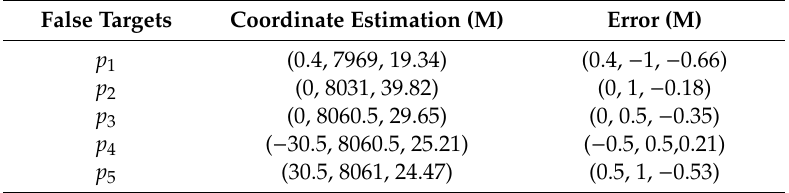
Figure 3. False point targets simulation based on three transponders. ( a ) SAR image in the antenna A 1 . ( b ) Absolute interferogram after unwrapped. ( c ) DEM of the false targets. ( d ) A slice graph of DEM of the false targets in ground range. ( e ) A slice graph of DEM of the false targets in azimuth. Table 4. Coordinate estimation and errors of false targets based on three transponders.